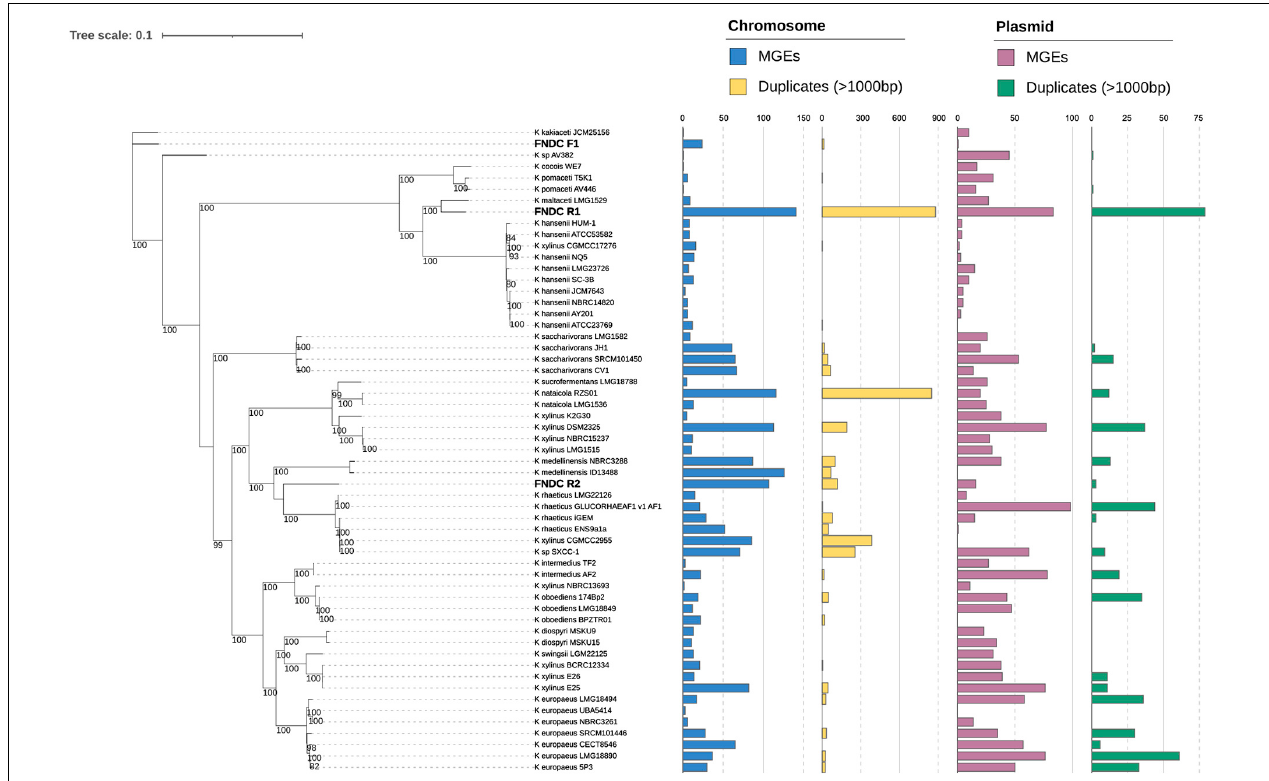
FIGURE 5 | Maximum-likelihood phylogenetic tree in Komagataeibacter genus. A maximum-likelihood phylogenetic tree was built using IQ-TREE based on the public Komagataeibacter genomes and the present strain genomes (FNDCR1, FNDCF1, and FNDCR2). The numbers at nodes are the bootstrap values > 80% as a percentage of 1,000 replications. The bar plot on the right shows the number of mobile genetic elements (MGEs) and Duplicates > 1,000 bp, respectively, on the chromosome and plasmid. The term “Duplicates” refers to homologous sequence pairs in the genome, as detected by RepSeek. MGEs and Duplicates on chromosomes, respectively, correspond to cyan and yellow, whereas MGEs and Duplicates on plasmids, respectively, correspond to pink and